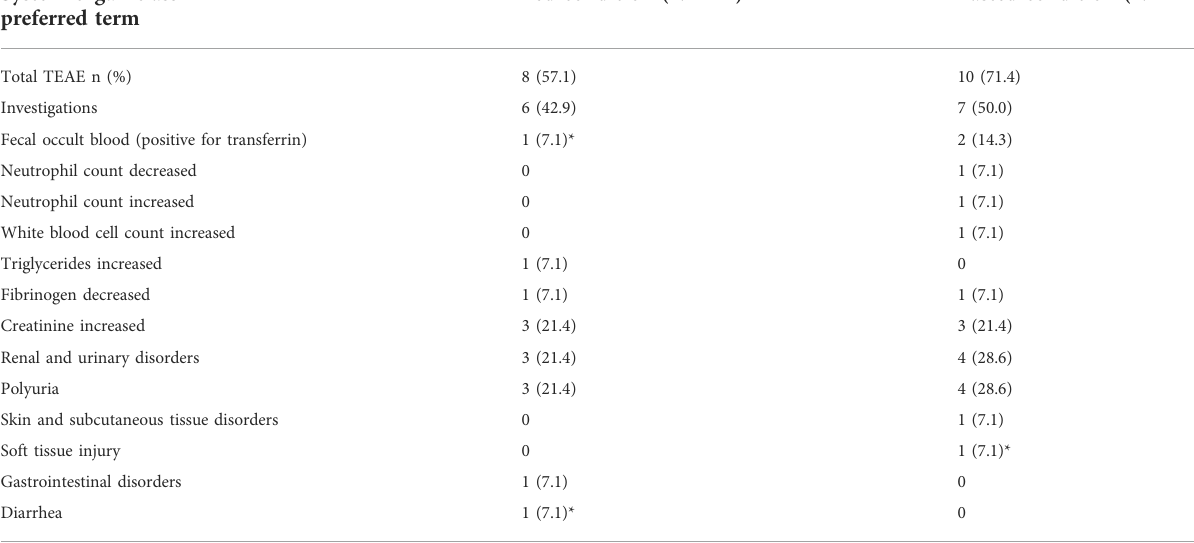
TABLE 4 Summary of treatment emergent adverse